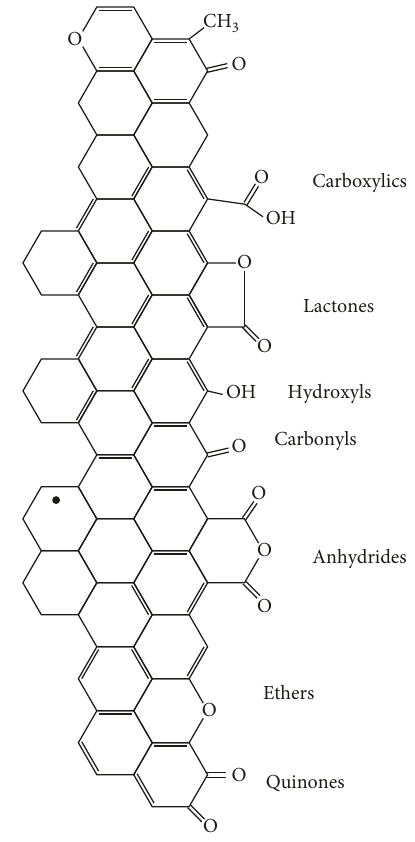
Figure 10: Schematic representation of the main superficial groups found on a carbonaceous supports.